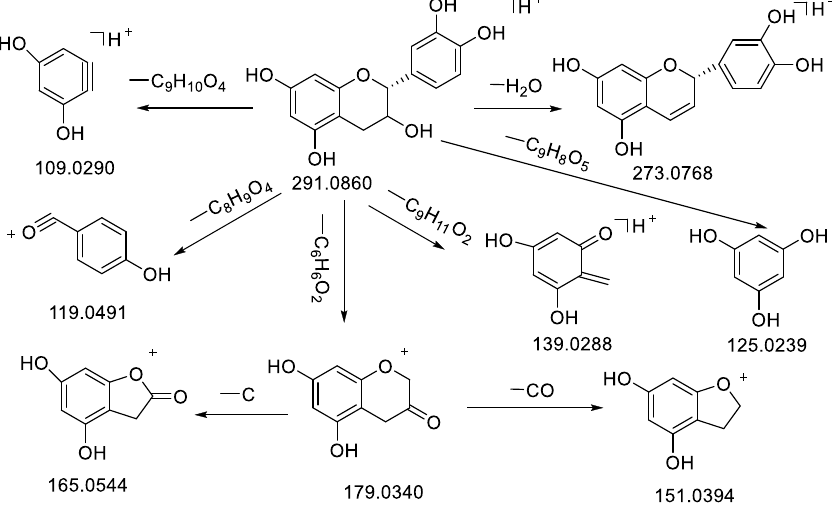
Figure 3. Fragmentation pathway of epicatechin in positive ion mode.